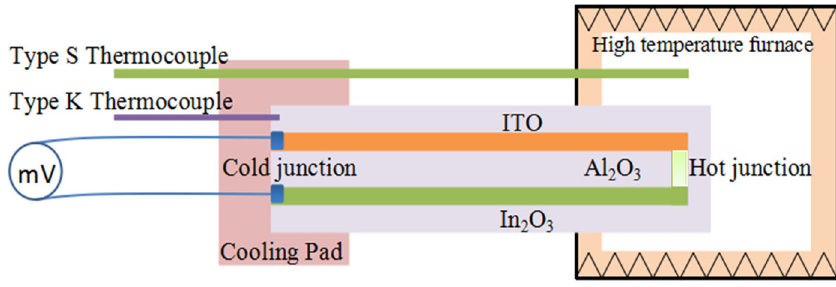
Figure 2. Schematic of ITO/In 2 O 3 thermocouple test set-up.